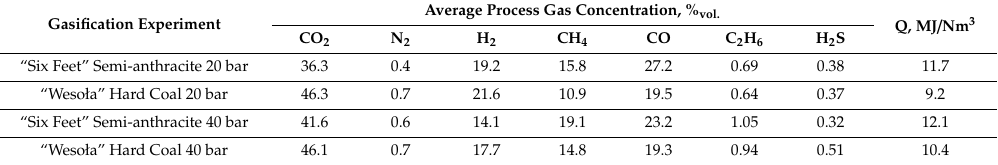
Table 4. Average gas compositions obtained during the four UCG experiments conducted.